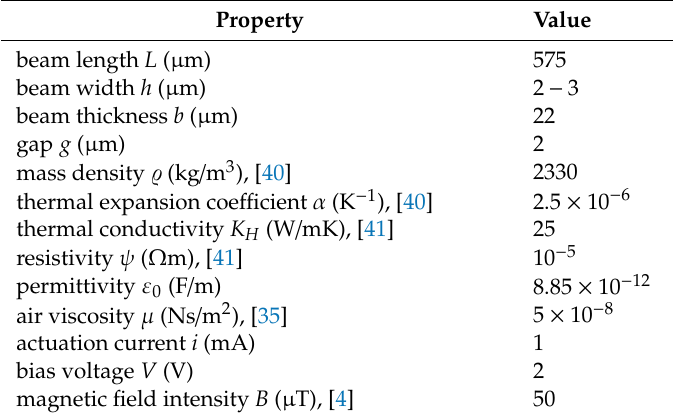
Table 2. Values of the geometrical, physical, actuation, and sensing parameters adopted in the analysis.